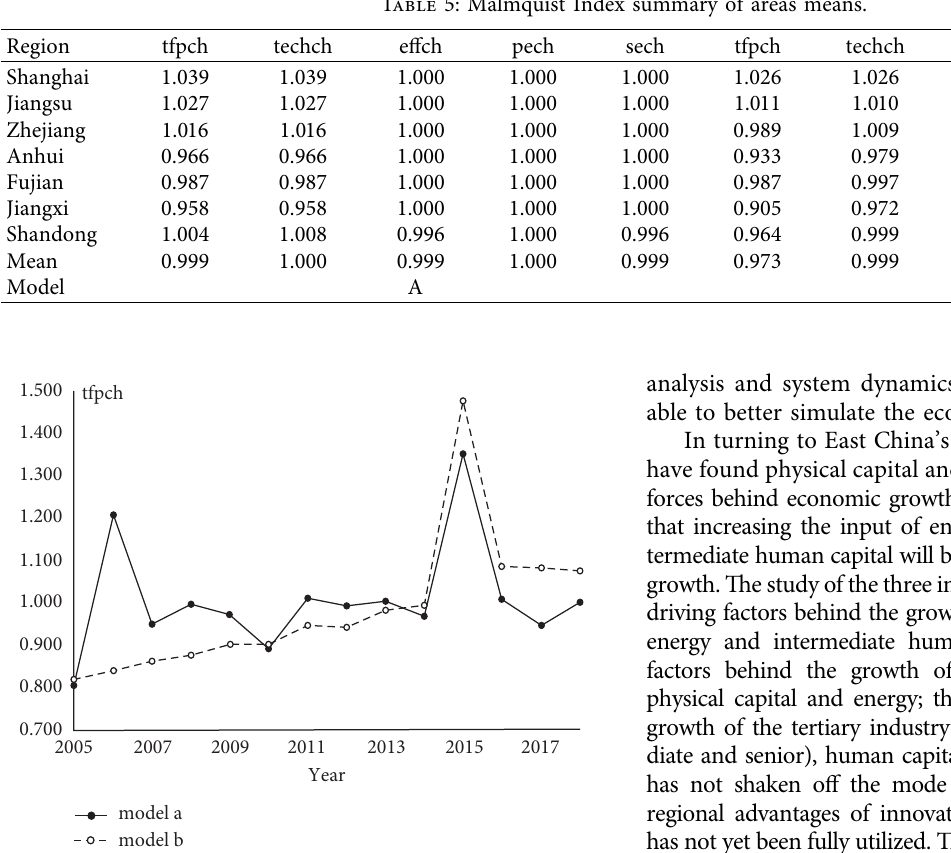
Figure 3: Trend of simulation results of model A and B.